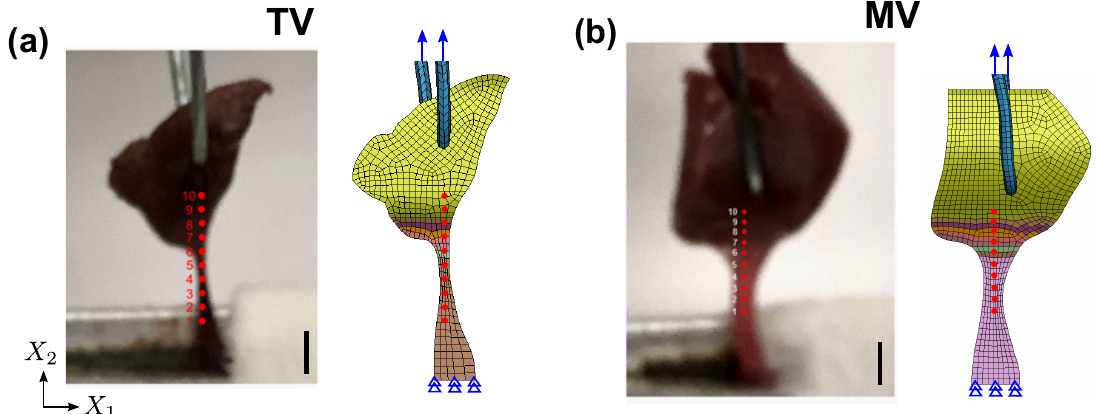
Figure 7. Virtual matched pair test setup for porcine ( a ) TV and ( b ) MV specimens with fiducial markers shown in red. Scale bar represents 3